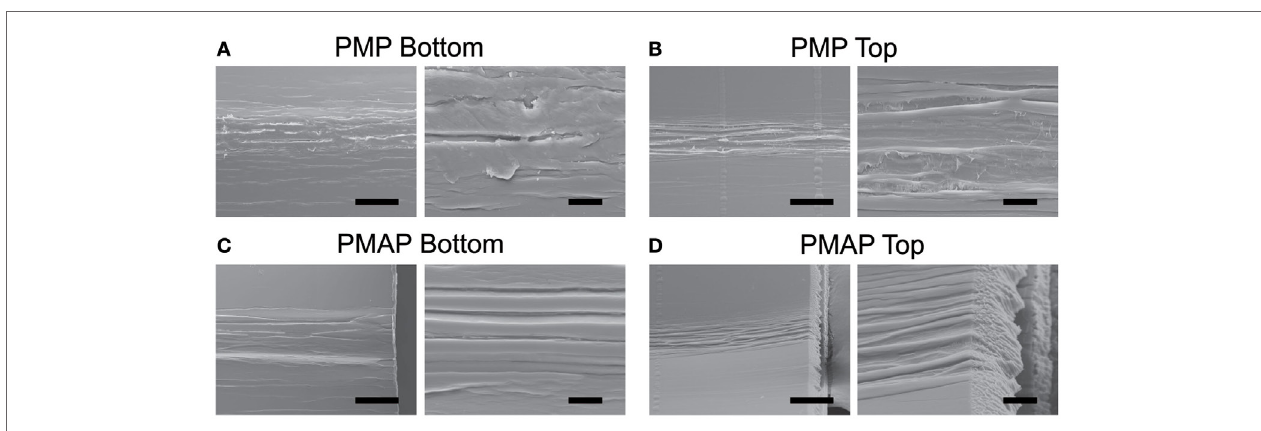
side of each panel are zoomed in views of images on the left with scale bars of the left and right images being 50 and 10 μ m, respectively. Parylene sputtered coated with Pt before imaging). In the PMAP sample, delamination at the bend was observed.